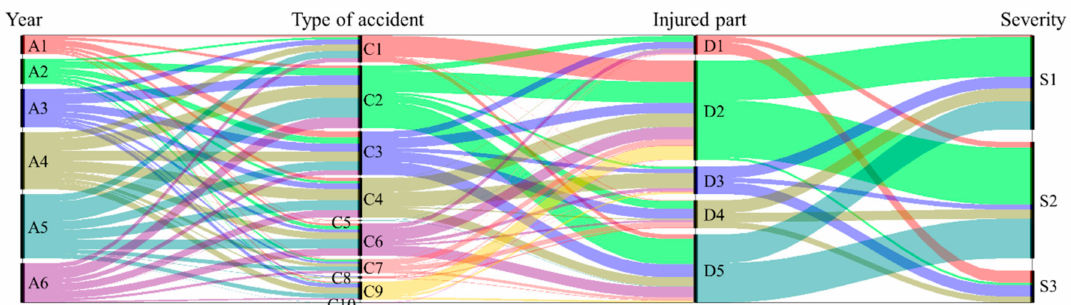
Figure 7. Alluvial flow diagram using variables with large correlation in prediction of severity. A: